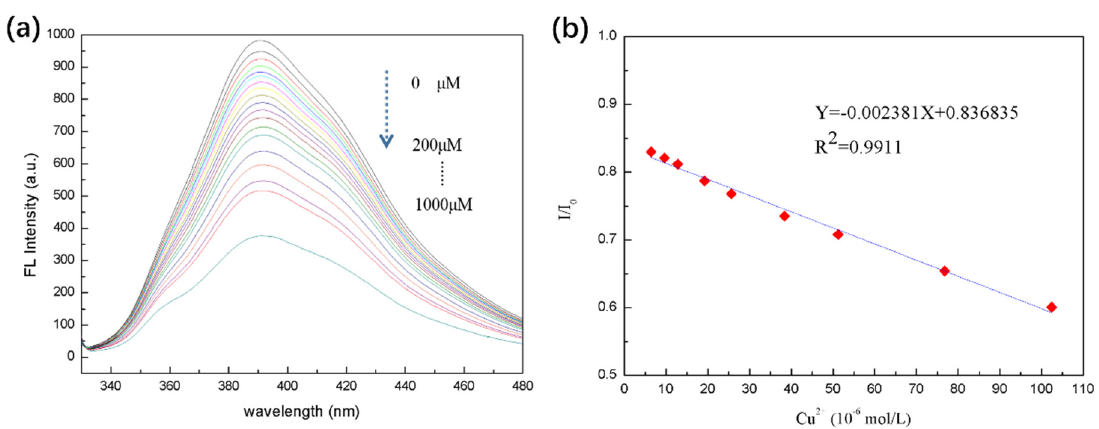
Figure 8. ( a ) Fluorescent response of 8PEG-AgNCs in the presence of various metal ions ( λ ex = 310 nm, λ em = 393 nm, C metal =100 μ M, C Cu2+ = 100 μ M). ( b ) Fluorescence emission spectra of 8PEG-AgNCs upon addition of various quantities of Cu 2+ (0–1000 μ M).